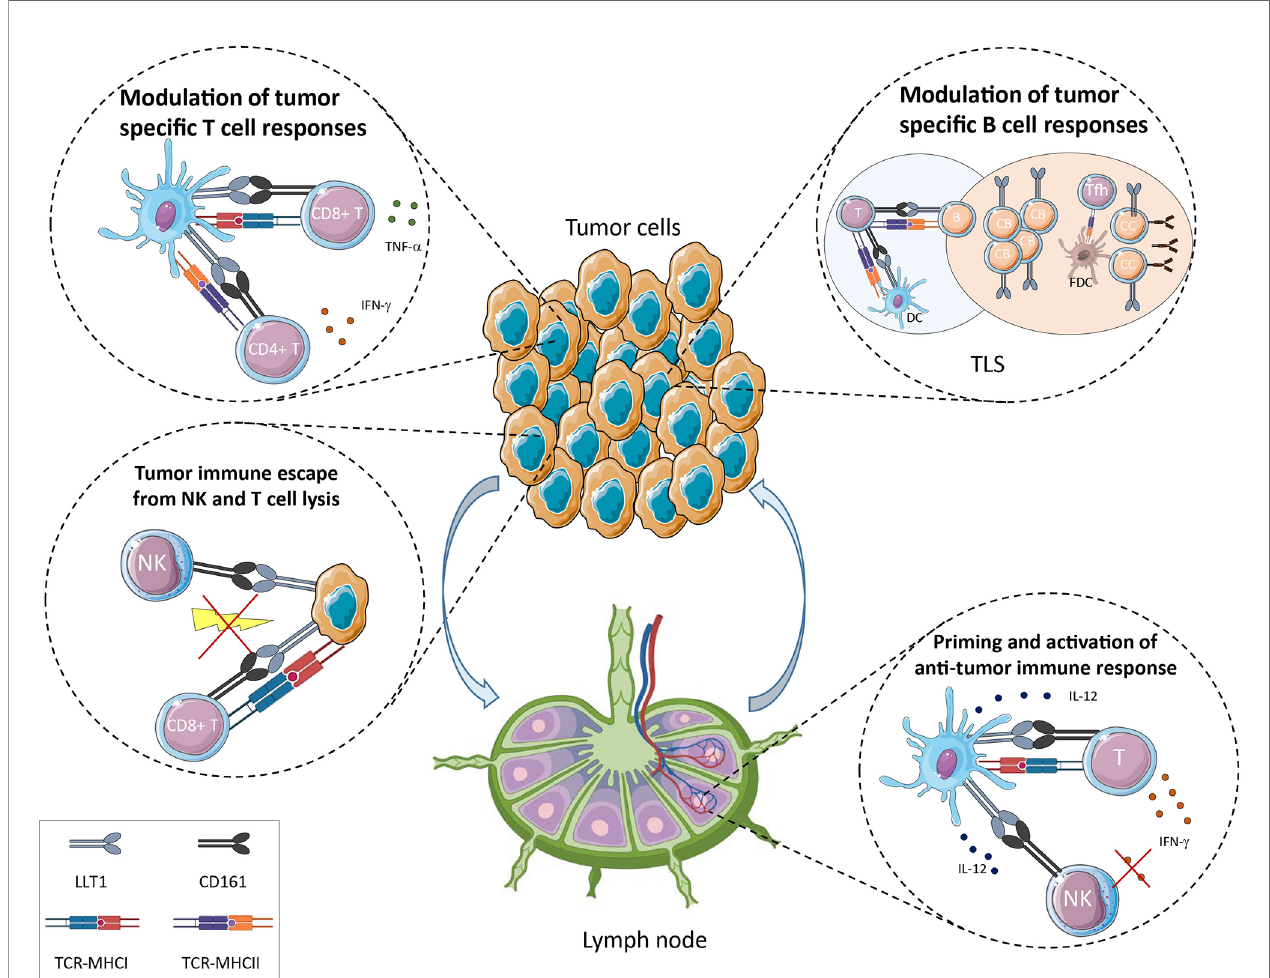
FIGURE 2 | Potential role of LLT1/CD161 interaction in cancer immune